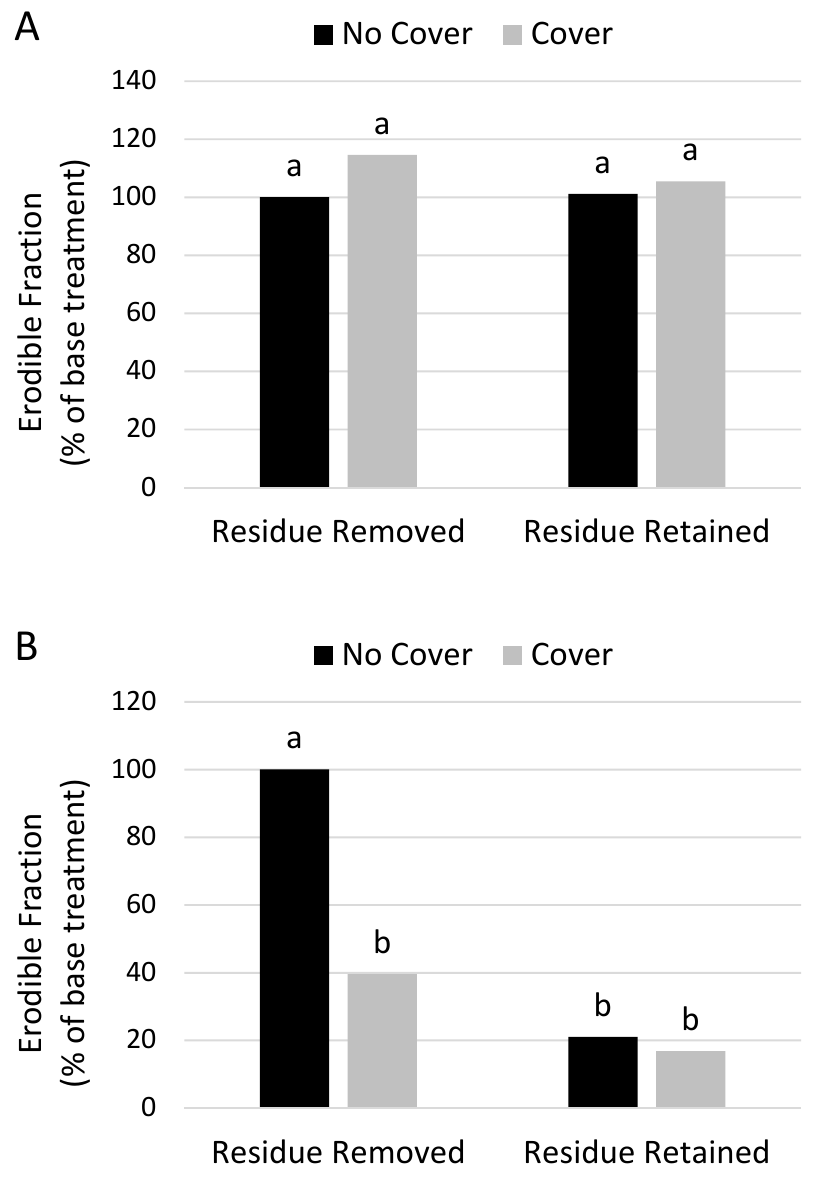
Figure 5. Erodible fraction of the soil in the 0–5 cm depth interval; values are means ( n = 3) for each treatment expressed as percentages of the mean for the default management treatment with corn residue removal and no cover crop. ( A ) Corn phase. ( B ) Soybean phase. Values marked with the same letter within the aggregate group are not different at α = 0.10, Tukey’s test. Values in this graph are calculated from selected data published in [24] and presented with revised statistics for the selected data.